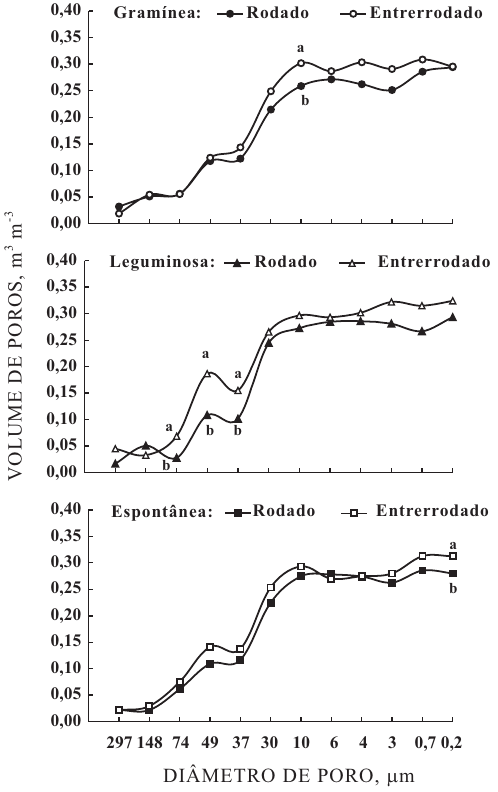
Figura 2. Volume de poros drenados para os diâme- tros de poro para as vegetações (gramínea, leguminosa e espontânea) e posições de amostragem (rodado e entrerrodado). Médias seguidas da mesma letra, dentro da mesma ve- getação e diâmetro de poro, não diferem entre si pelo teste F a 5 %.